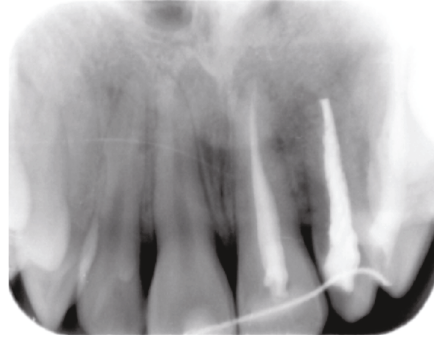
Figure 13: Healing at 6-month follow-up, X-ray.